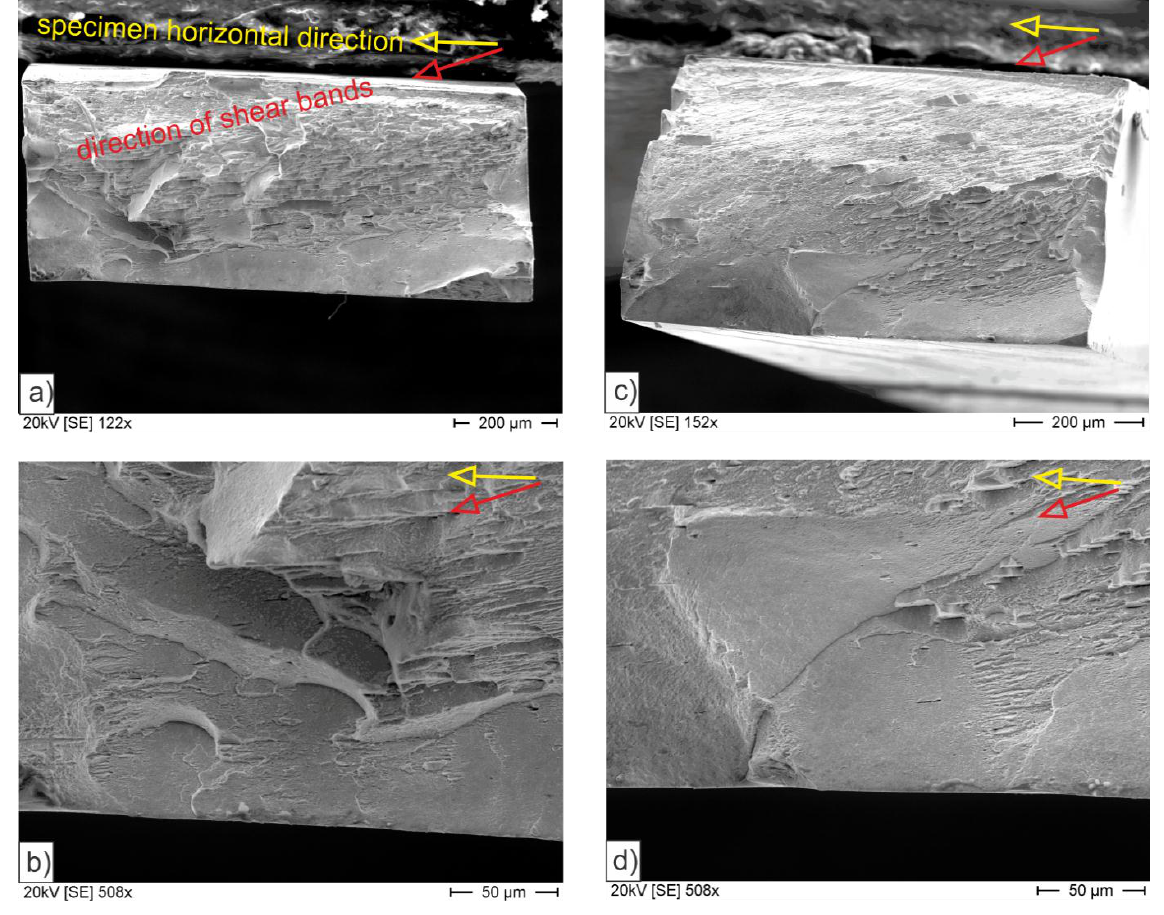
Figure 11. Fracture surface of t-HPT-10 state which shows shear bands ( a , b ) loaded at 900 MPa and ( c , d ) loaded at 850 MPa (red open arrows at the top indicate the direction of shear bands in correlation to the specimens surface indicated by the yellow open